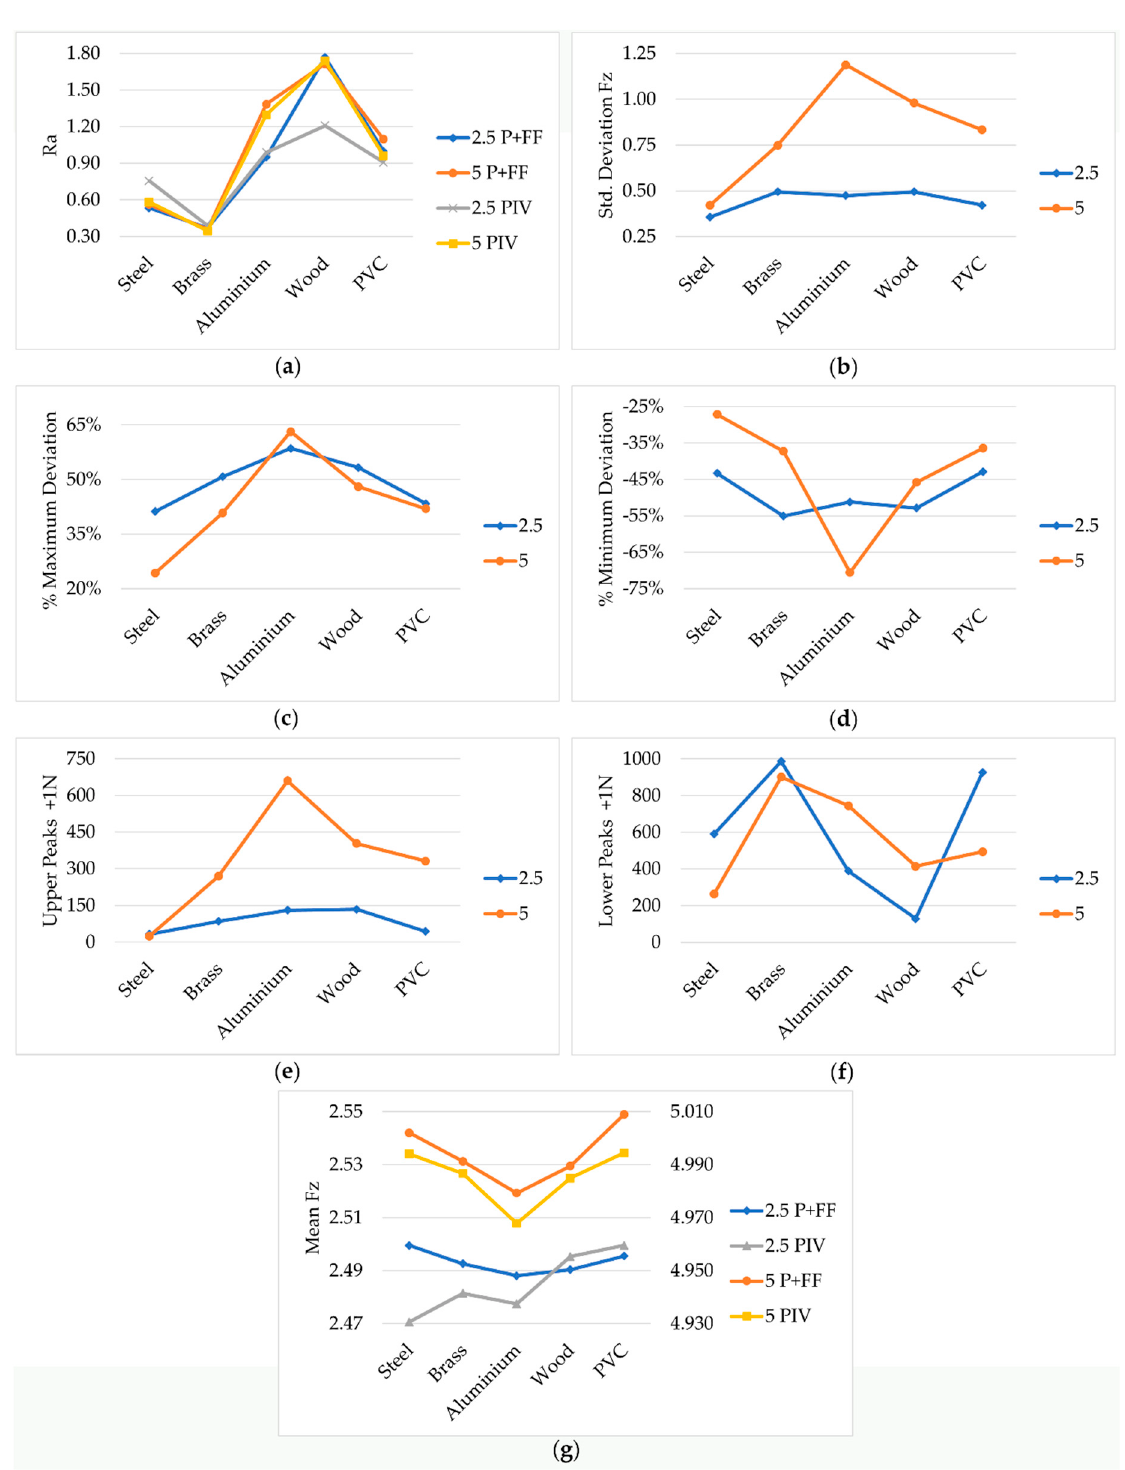
Figure 2. Marginal means. ( a ) Surface roughness, ( b ) standard deviation, ( c ) maximum deviation, ( d ) minimum deviation, ( e ) number of upper peaks, ( f ) number of lower peaks, ( g ) mean of contact force.